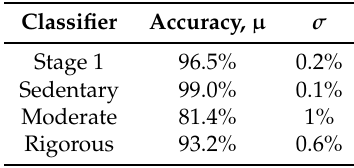
Table 1. Off-Board Classification (accelerometer only).